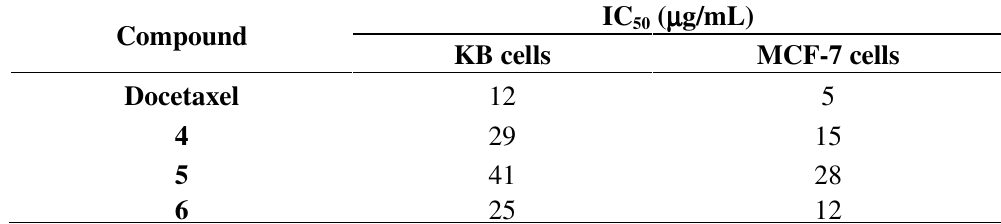
Table 2. IC values of docetaxel and docetaxel prodrugs 4 – 6 50